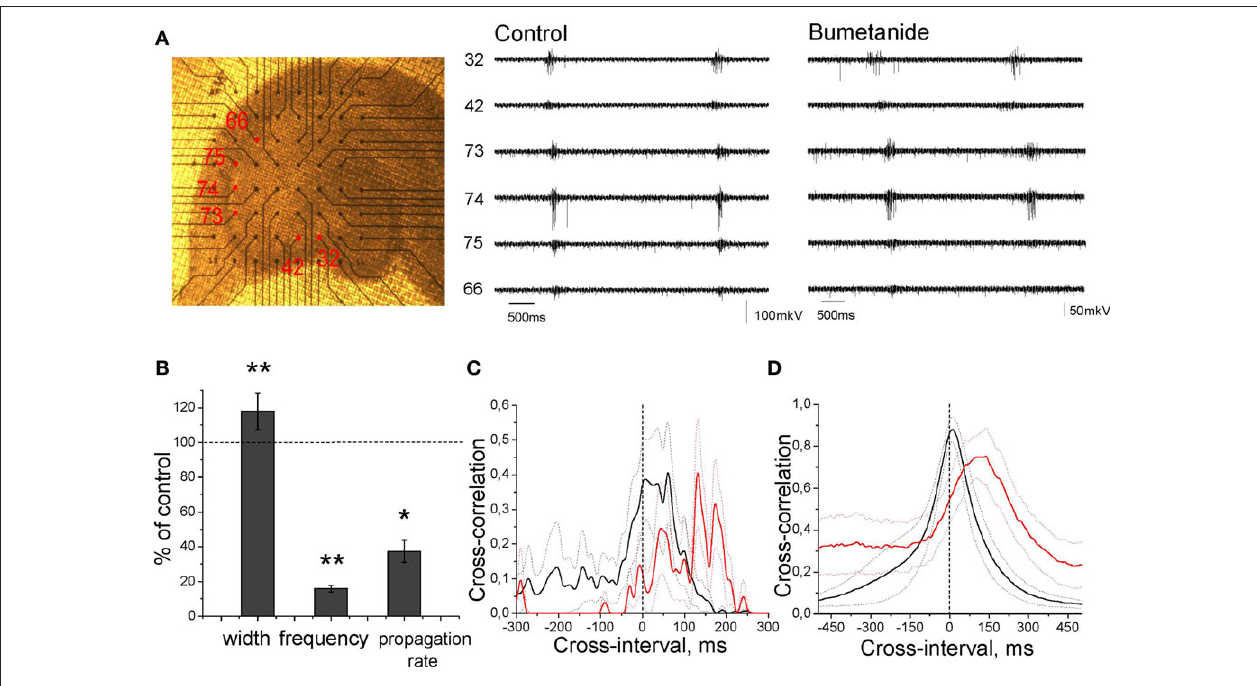
Figure 9 | effect of partial blockade of NKCC1 on gDPs. (A) Photograph of the recording setup and extracellular GDP recordings in control conditions (left traces) and in the presence of 0.3 μM bumetanide (right traces). (B) Normalized GDPs width, frequency, and propagation rate in the presence of 0.3 μM